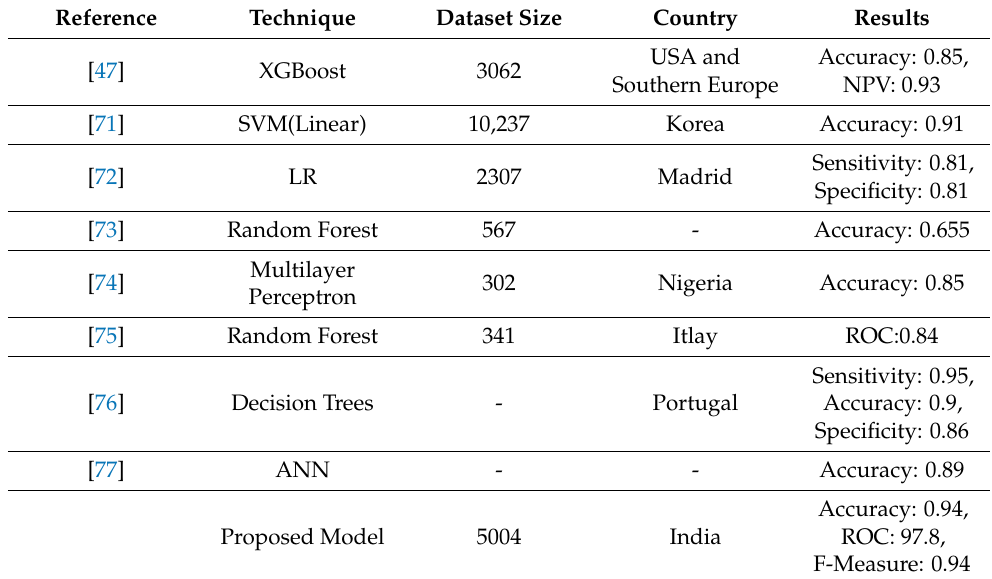
Table 4. Comparison of relative studies using ML models with the proposed Fine-tuned Ensemble